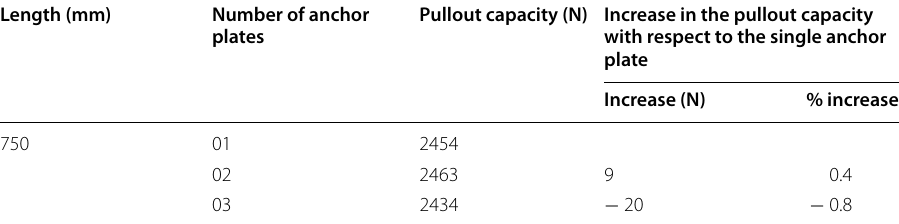
Table 10 Effect of number of anchor plates on the pullout capacity for a 50 mm diameter and 750 mm long single GPA